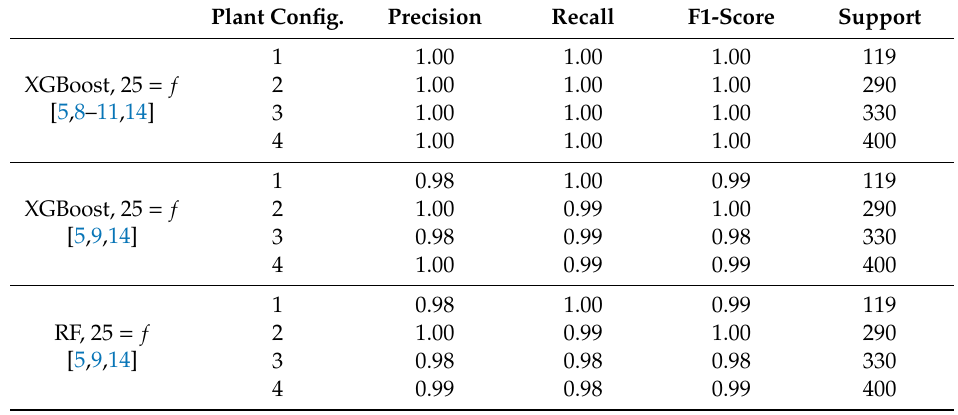
Table 14. Validation—selected environmental and biometric data for plant configuration identification. Plant Config. Precision Recall F1-Score Support XGBoost, 25 = ƒ